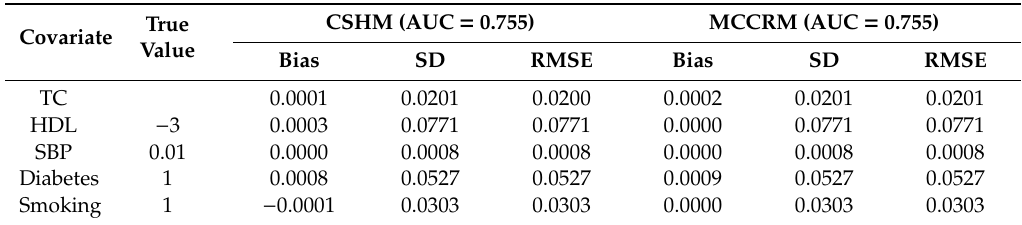
Table 1. Comparison of the coe ffi cients of the two models.